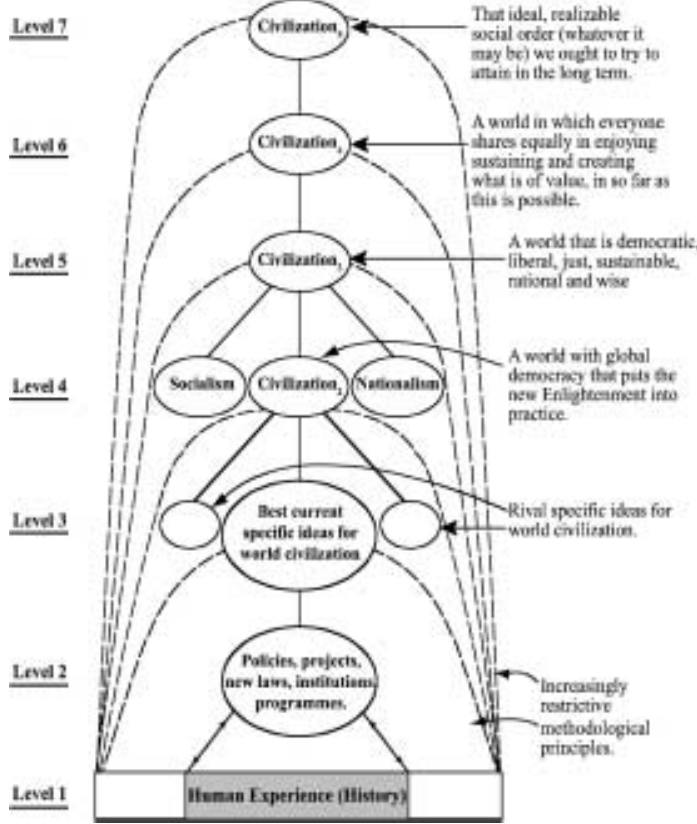
Figure 3. Hierarchical social methodology generalized from